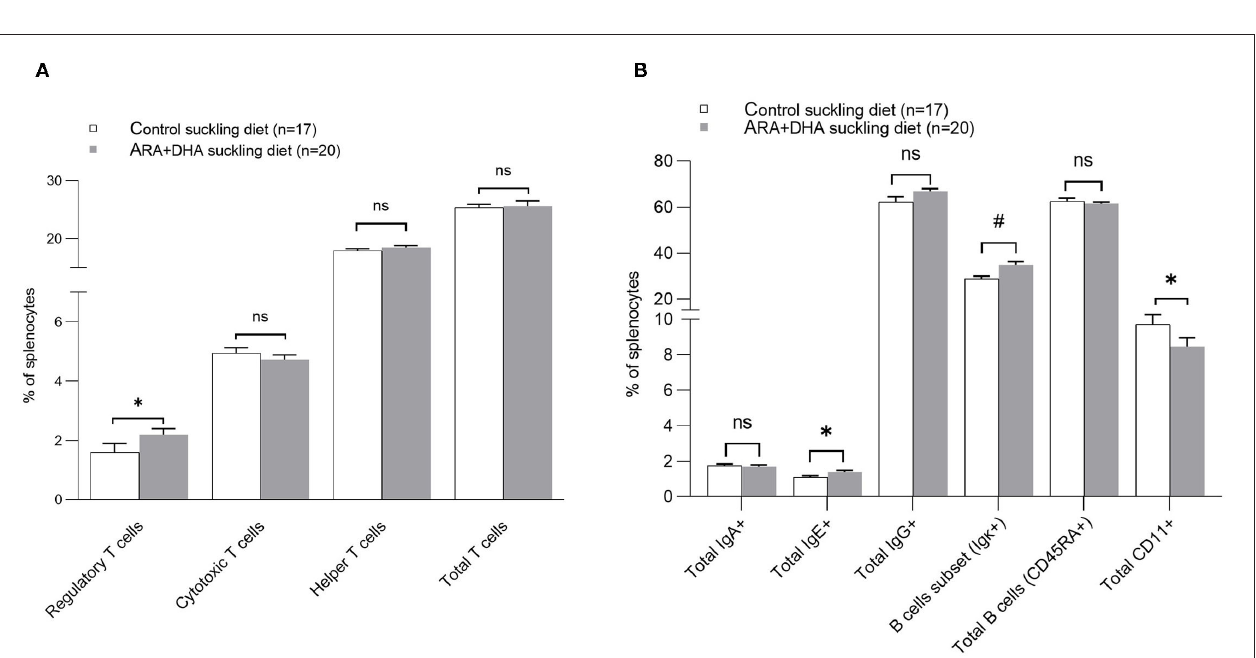
FIGURE 3 | The effect of post-weaning diet on the ex vivo cytokine production after phorbol-myristate-acetate and ionomycin (PMAi) stimulation of splenocytes from 8 weeks offspring. Values are presented in mean ± SEM. (A) The post-weaning diet group comparison for IL-2 ( p = 0.55), TNF- α ( p = 0.02) and IFN γ ( p = 0.04). The interaction of suckling diet and post-weaning diet main effects ( P -interaction < 0.01) on ex vivo IL-6 production to PMAi stimulation is shown in (B) . The p- values for suckling diet and post-weaning diet are p = 0.81 and p = 0.92. Post - hoc differences are calculated using LSMEANS in the mixed model. The groups that do not share the same letter are significantly different. Note, Supplementary Table 4 reports the mean ± SE for the 4 diet groups as per the SD × WD interaction analysis. *, indicates statistical significance was assumed at P < 0.05.